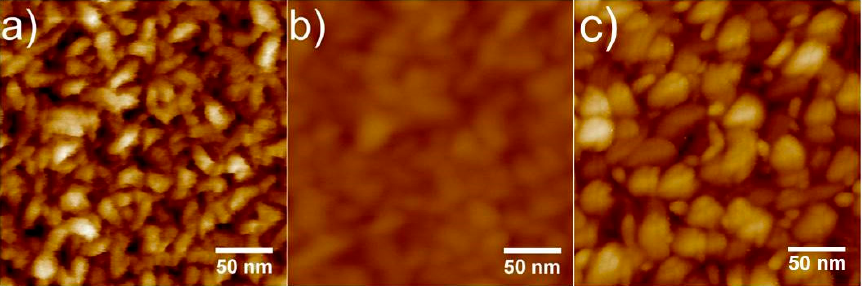
Figure 3. AFM images of the Nioprobe tip calibration sample in PeakForce tapping (PFT) mode using ( a ) probe CNT1 and ( b ) a new silicon FMV probe (nominal tip diameter of 20 nm) and ( c ) a new ScanAsyst probe (nominal diameter of 4 nm) The height or color scale for all images is 20 nm.